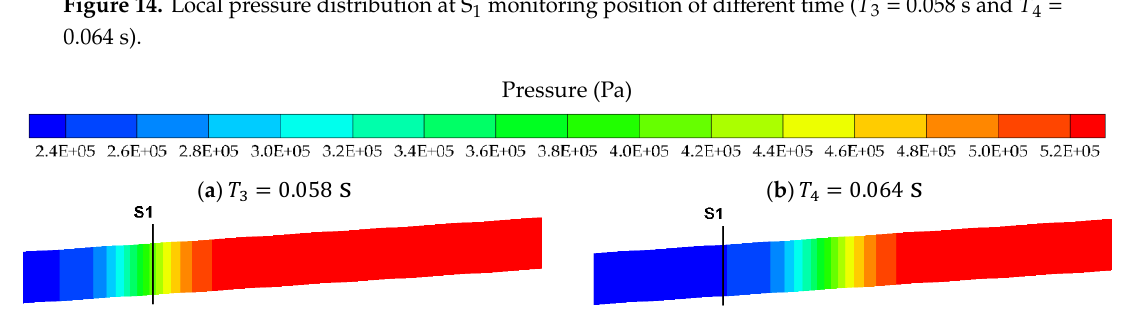
Figure 15. Pressure field evolution on the axis plane of the pipeline ( 𝑇 3 = 0.058 s and 𝑇 4 = 0.064 s ) .